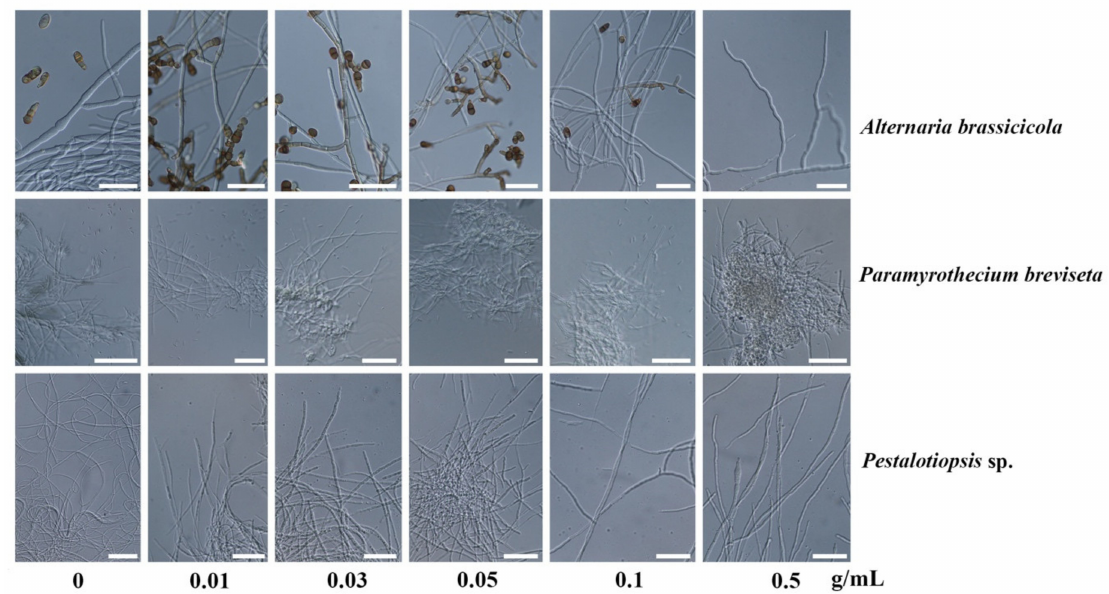
Figure 4. Effects of the crude methanolic fraction of coffee pulp powder on the fungal morphology of Alternaria brassicicola (CRC152), Pestalotiopsis sp. (CRC151) and Paramyrothecium breviseta (CRC12) after culturing on the poison food after 7 days of inoculation. The concentrations of poison food were prepared at 0, 0.01, 0.03, 0.05, 0.1 and 0.5 g/mL extract in the potato dextrose